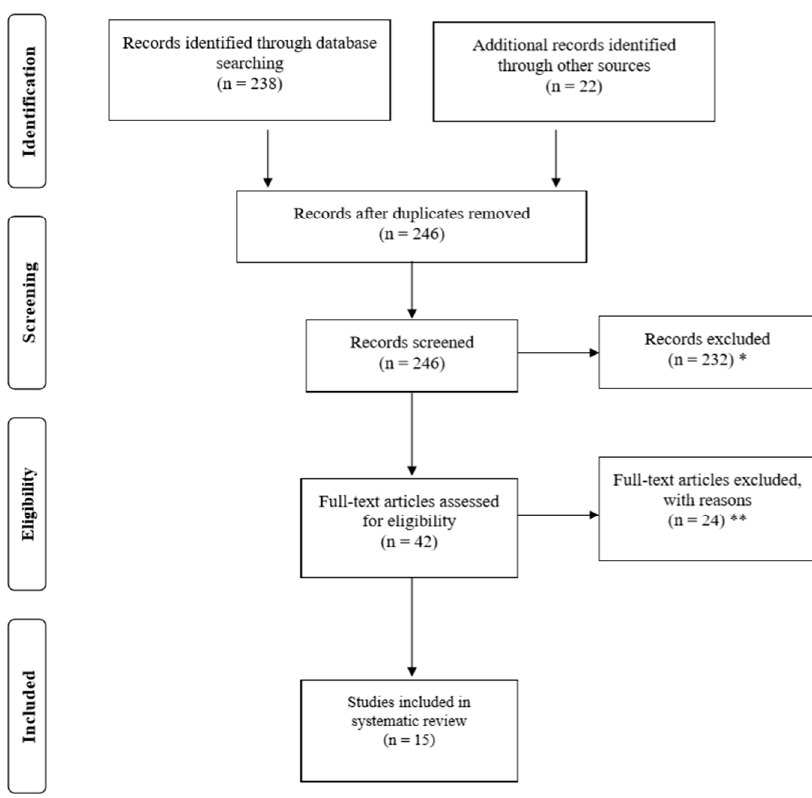
Figure 1. Flow diagram of studies through the review process. Note. * reasons for exclusions included ineligible age, ineligible exposure, ineligible analysis; ** reasons for exclusions included ineligible outcomes and lack of means/standard deviations.